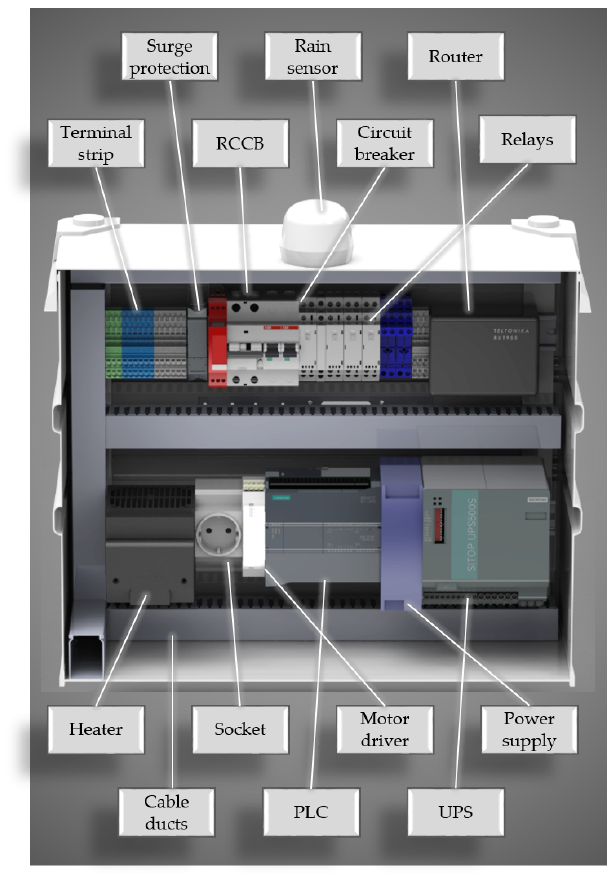
Figure 4. CAD model of the electrical components inside the en- closure.